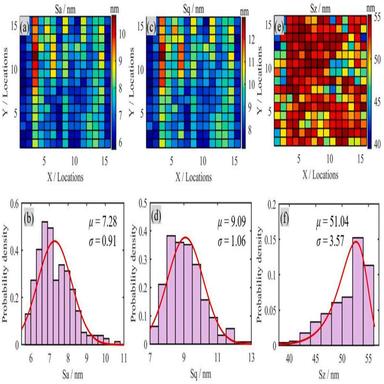
Surface texture parameters of different subarea scales at the machining conditions III of: Sa - (a) the calculated values and (b) the probability distributions, Sq - (c) the calculated values and (d) the probability distributions, and Sz - (e) the calculated values and (f) the probability distributions.